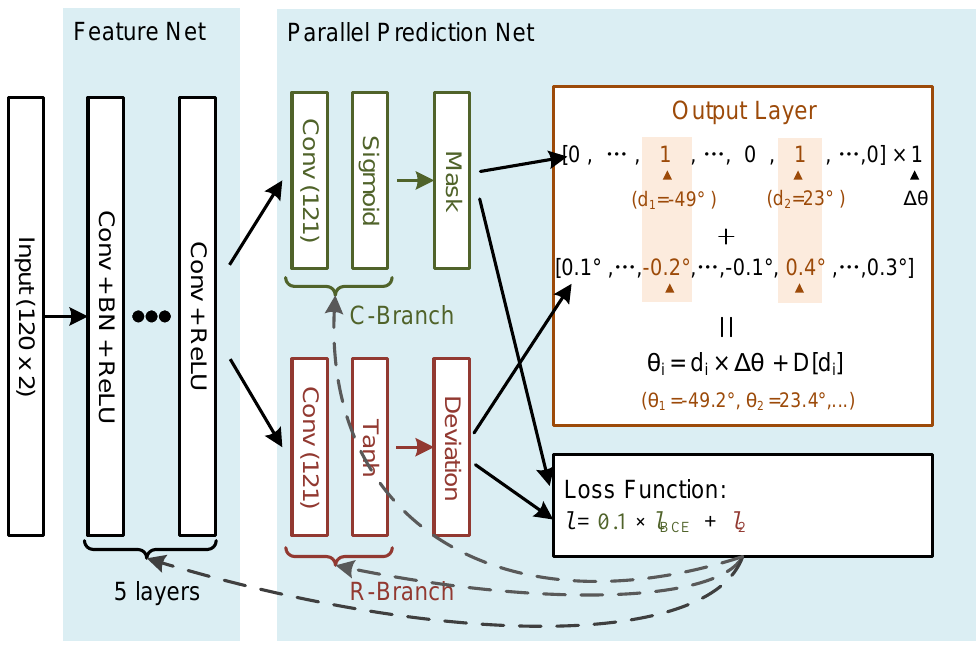
Figure 1. Architecture of the proposed